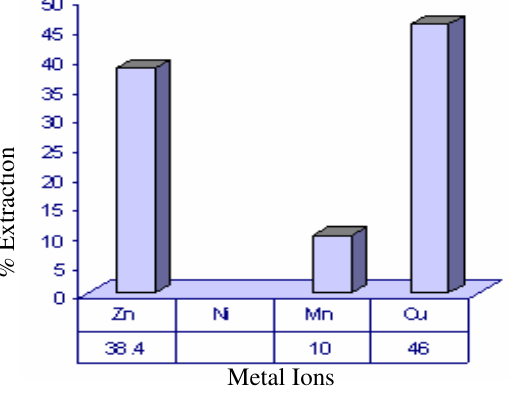
Figure 1 . The competitive metal ion extraction using MTTT as a